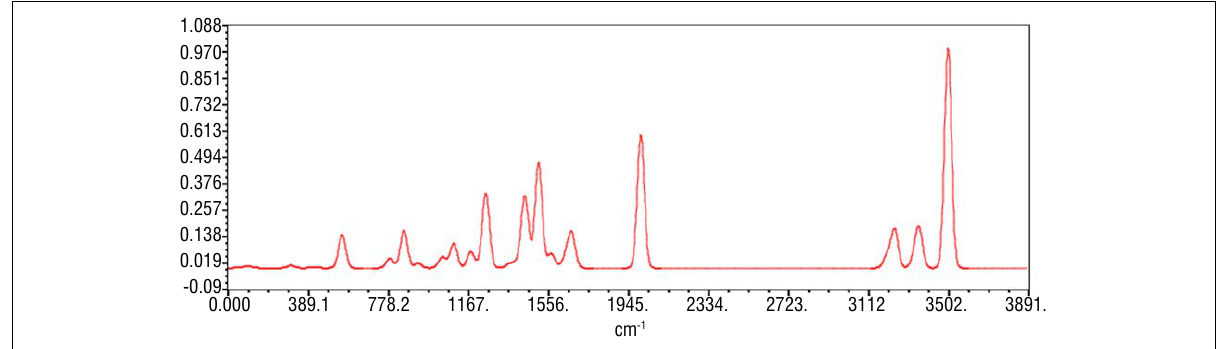
Figure 2: The infrared spectrogram of valeraldehyde lies between 0 and 3600 cm -1 .